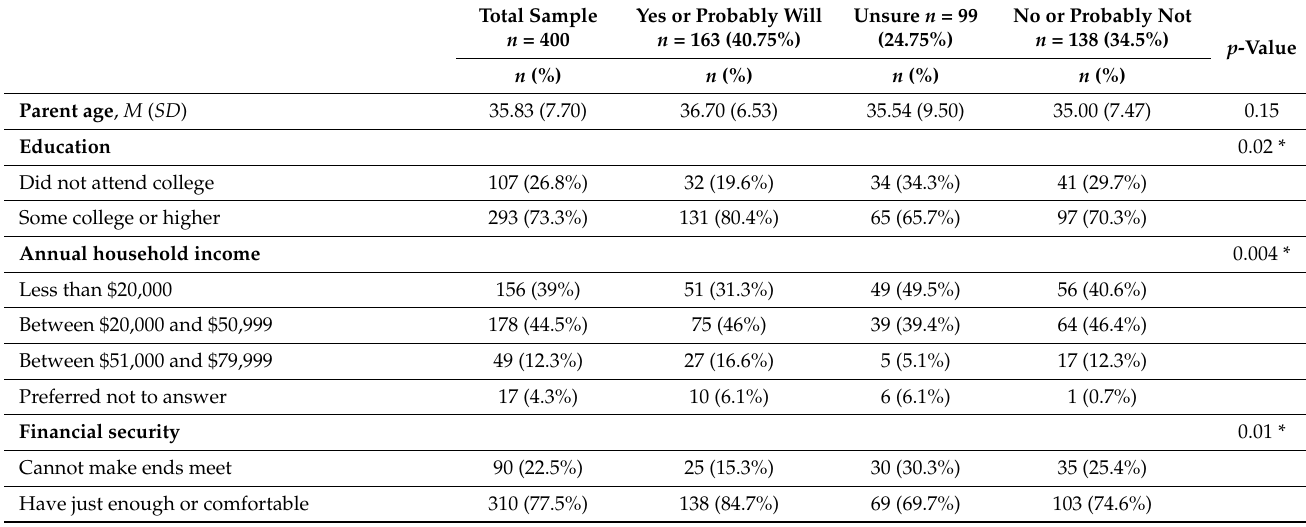
Table 1. Frequencies and percentages for parent and child characteristics and factors influencing vaccine hesitancy and acceptability by plans to vaccinate child against